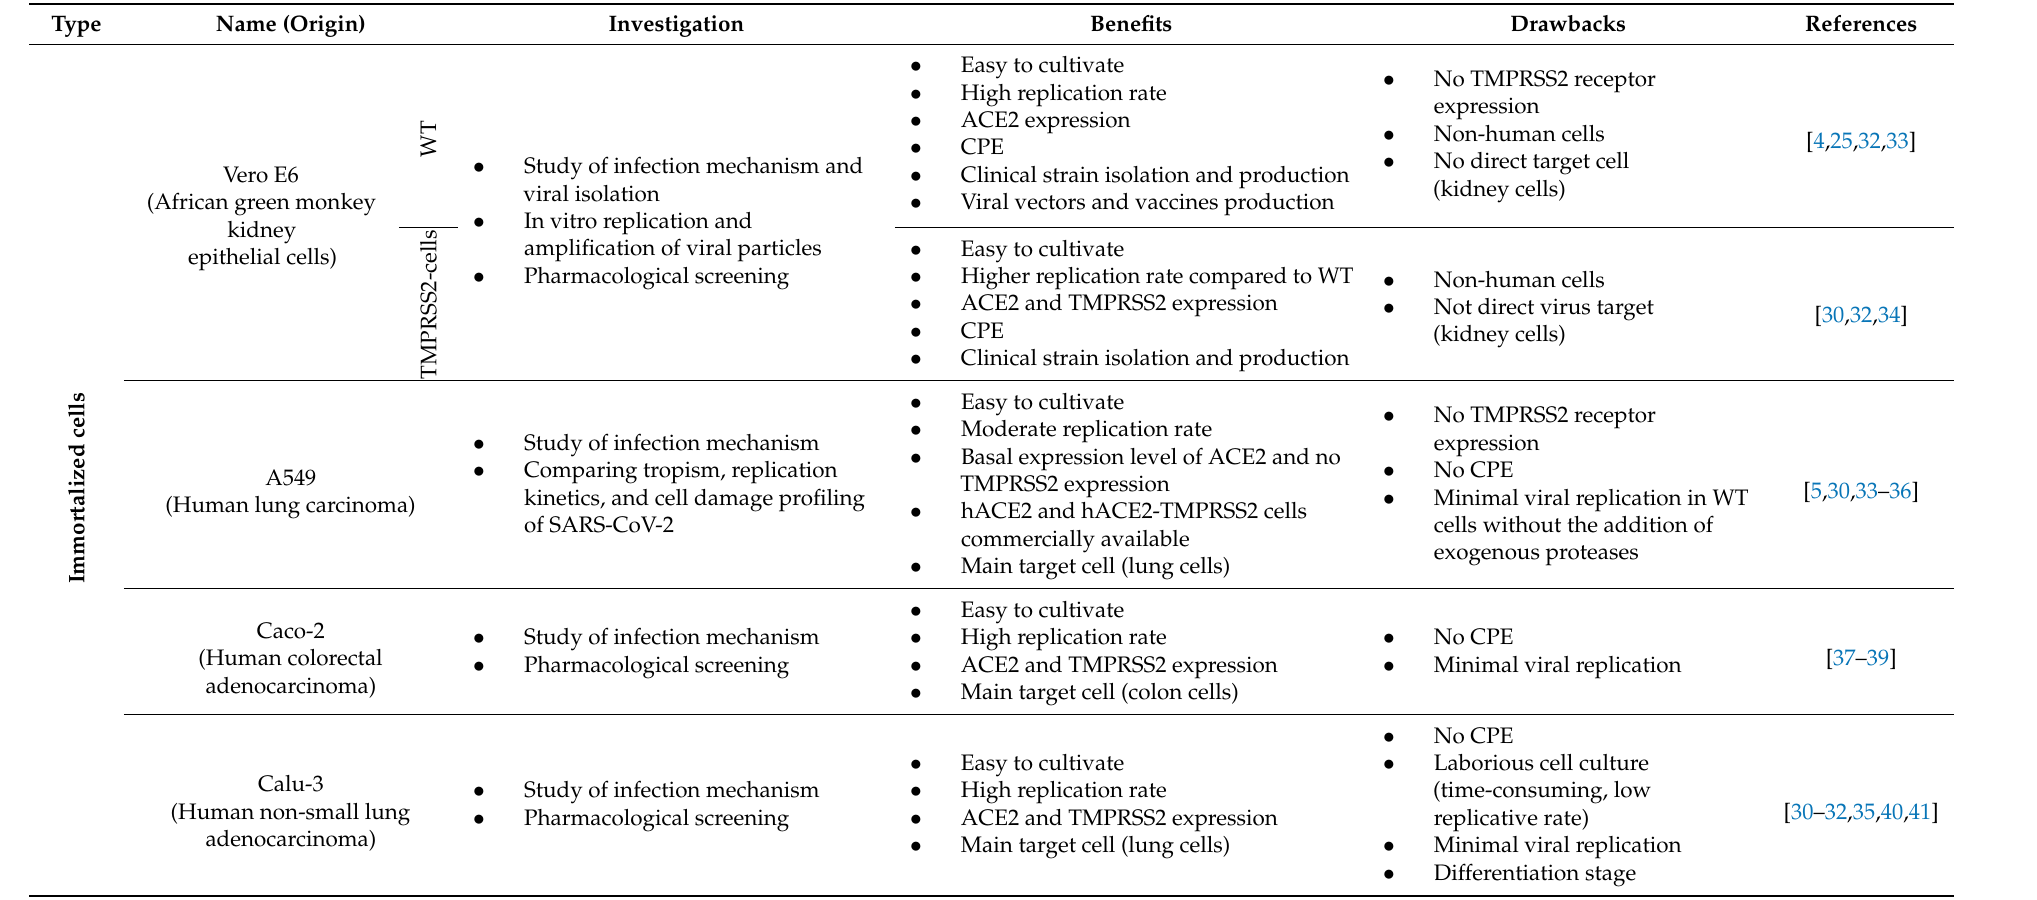
Table 1. Cell-based approaches: key points, benefits, and